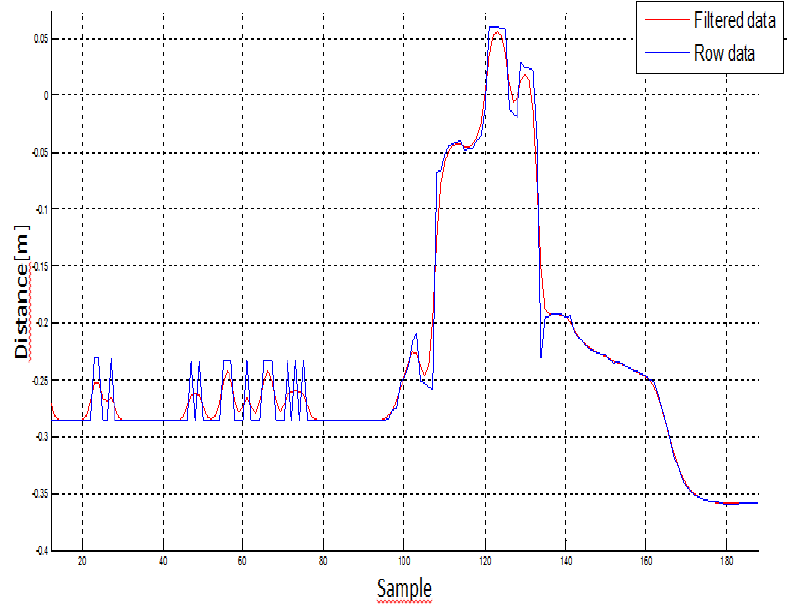
Figure 6. Result of filtering Kinect TM data with a Butterworth low pass